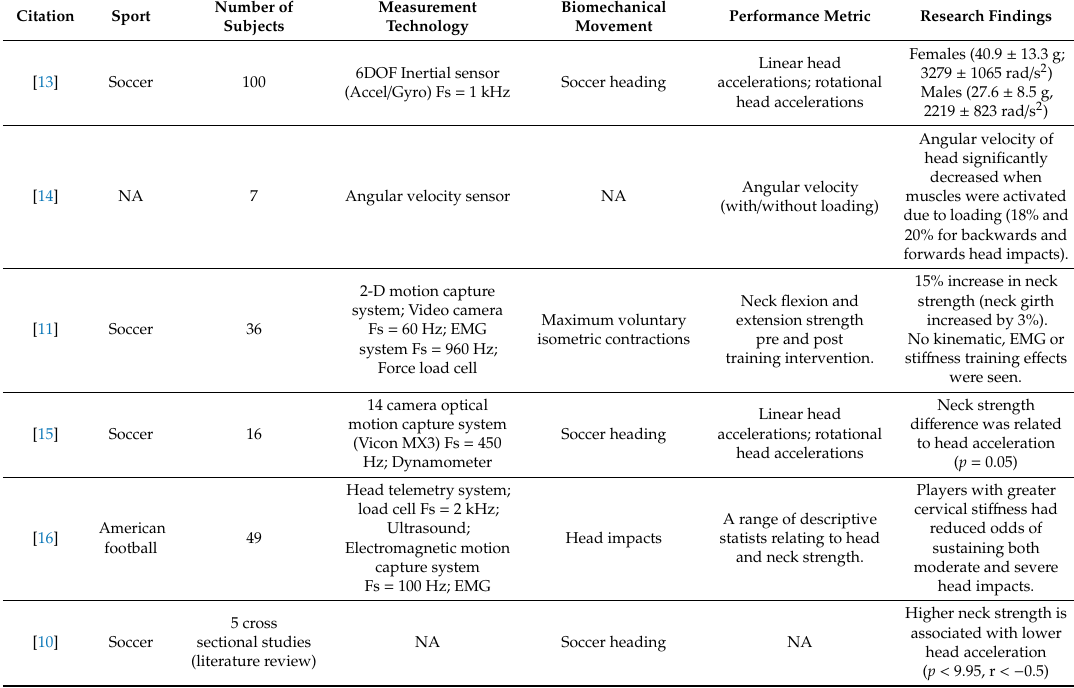
Table 1. Key descriptors and findings extracted from reviewed scientific literature investigating head impacts and neck